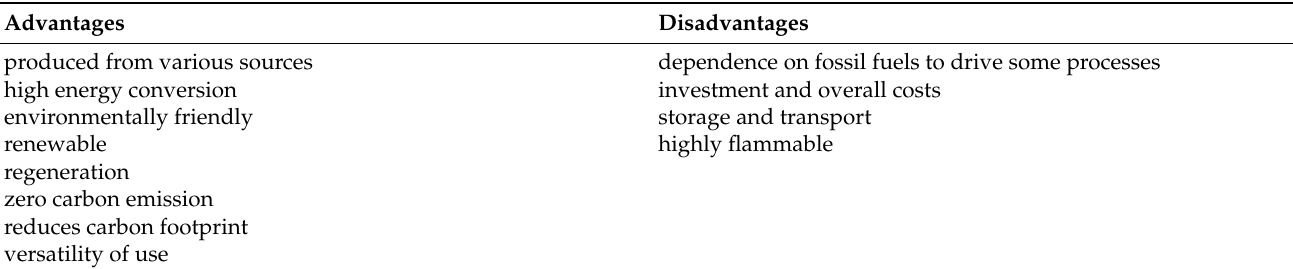
Table 1. Advantages and disadvantages of hydrogen as a fuel [6,7].